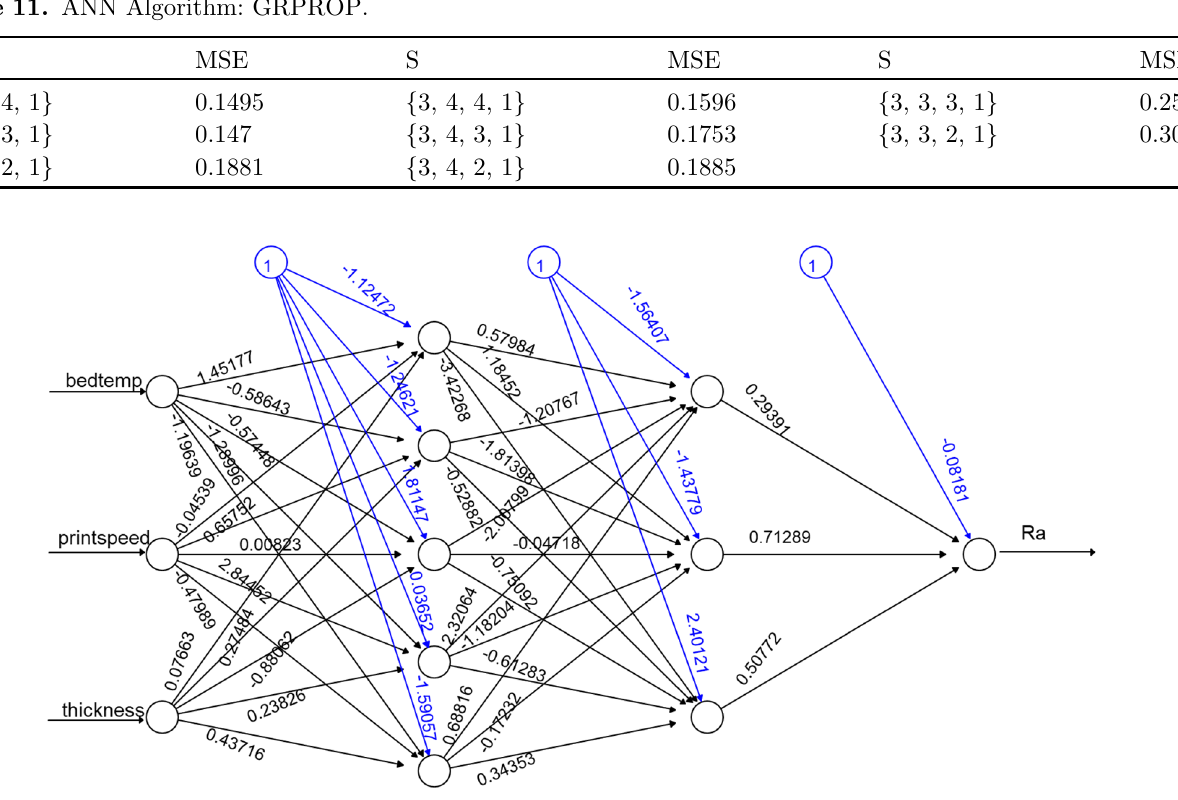
Fig. 14. Neural network: GRPROP, S= {3, 5, 3,